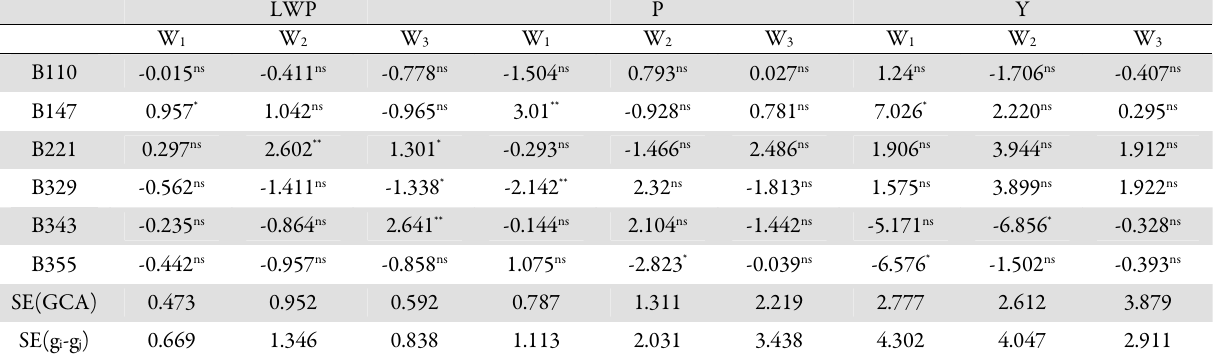
Tab. 3.2 Estimates of general combining ability of the female lines for leaf water potential (LWP), proline content (P) and yield (Y) at the different levels of irrigation. normal irrigation (W 1 ), mild water stress (W 2 ), severe water stress (W 3